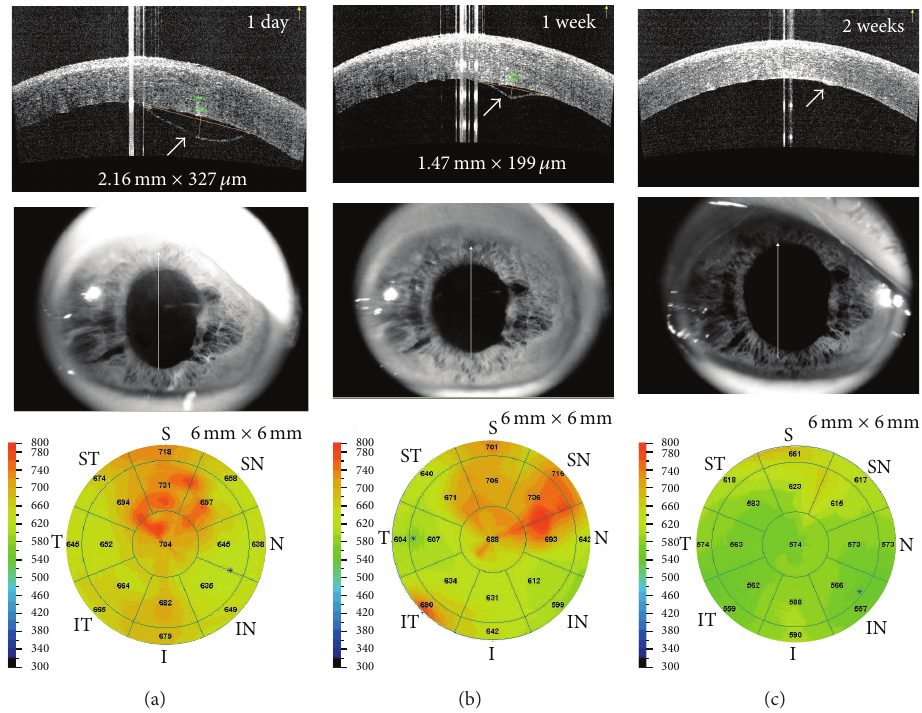
Figure 7: Spontaneous resolution of a detachment of Descemet’s membrane following phacoemulsification. Optical coherence tomography (OCT) images at 1 day after cataract surgery (a) demonstrated superior planar type DMD with diffuse corneal edema. OCT images at postoperative 1 week (b) and 2 weeks (c) revealed spontaneous resolution of DMD without